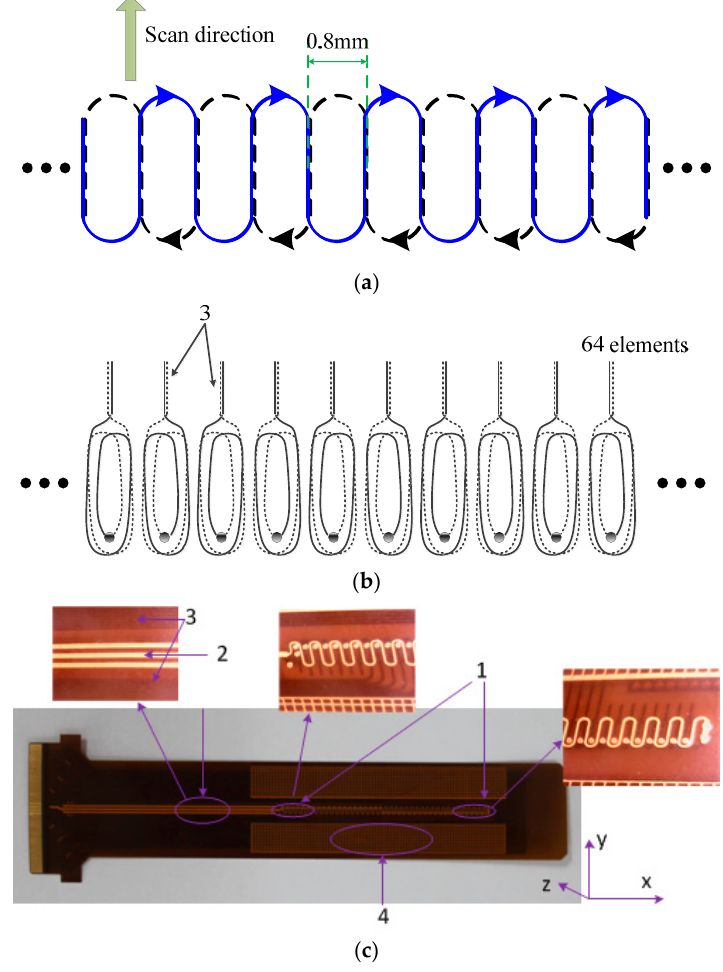
Figure 1. Novel sensor array ( a ) Schematic diagram of the exciting coil; ( b ) Schematic diagram of the sensing coil; ( c ) Actual sensor.